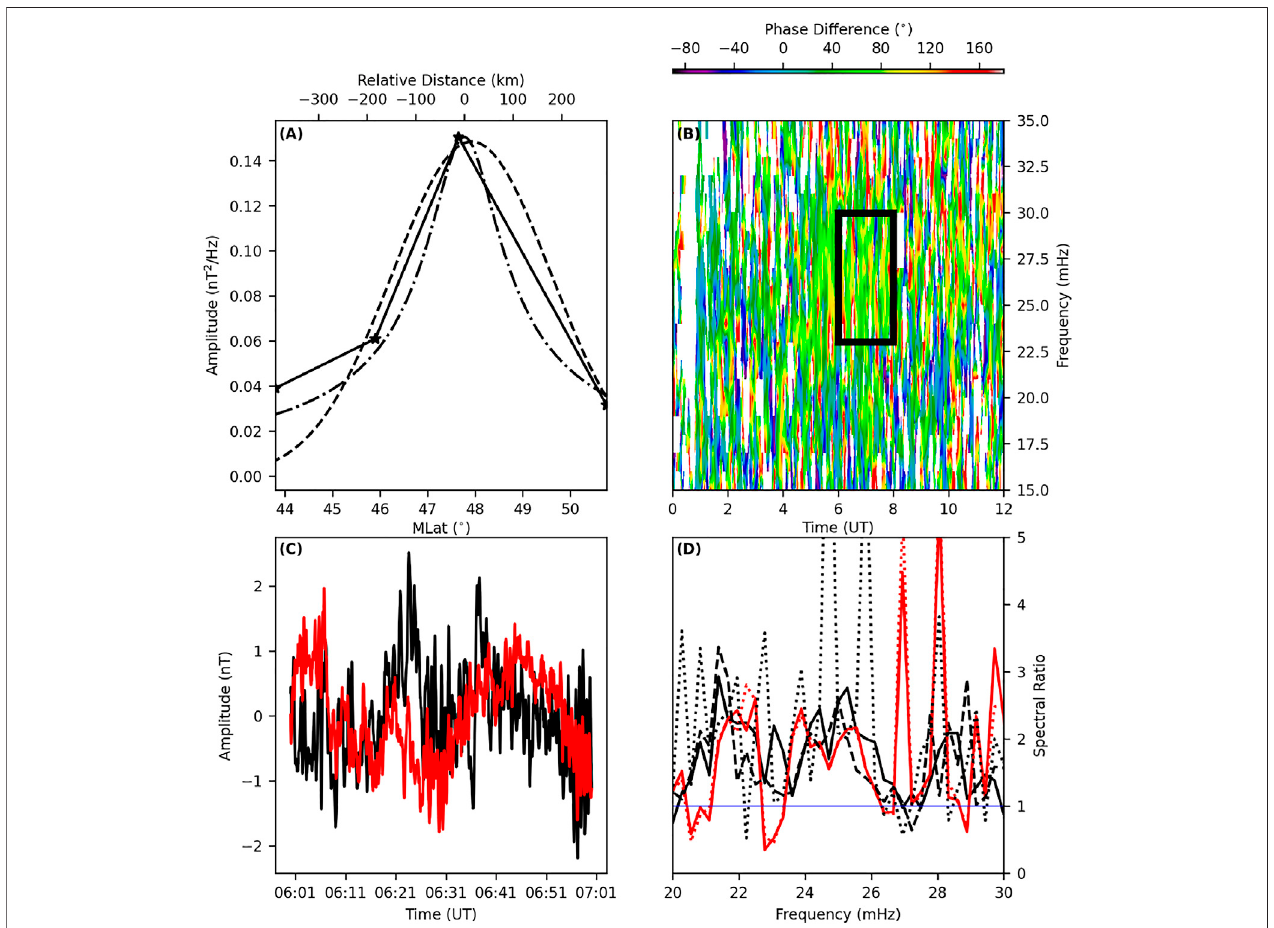
FIGURE 5 | (A) Latitudinal spectral amplitude curve fi ts; Linear piece-wise (solid, stars at station locations), Gaussian (dashed) and FLR amplitude ( Eq. 3 , dash- dotted) versus MLat/km, (B) Dynamic cross phase between NUR-TAR, (C) Time series of the NUR (black) and TAR (red) magnetometer stations, and (D) Spectral amplitude ratio for the boxcar (black, dotted), Hann (red, dashed), Hamming (red, solid), exponential taper (black, solid), and multi-taper (black, dashed) FFT window processing for the NUR-TAR magnetometer data for the 19 June 2015 interval.